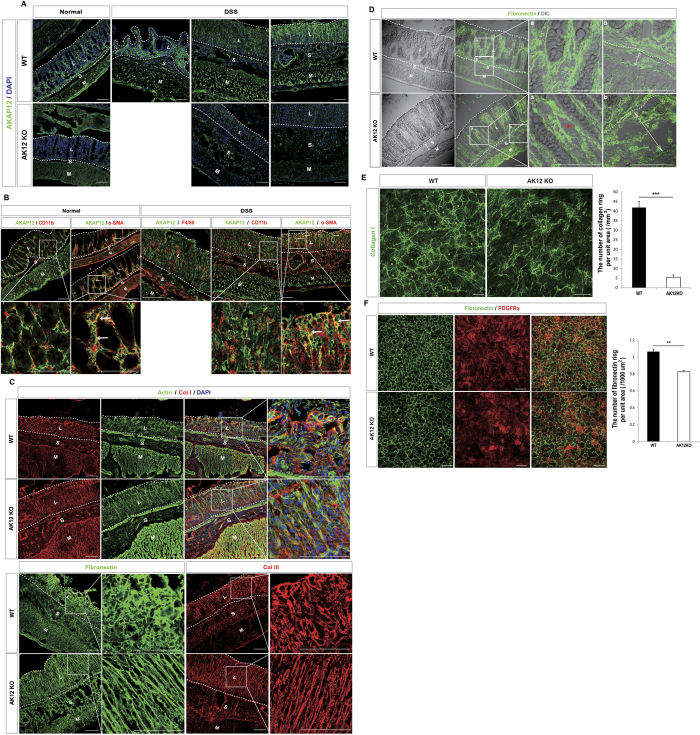
AKAP12+ CMCs regulates ECM organization.(A) Confocal imaging of AKAP12 expression in WT and AKAP12 KO colon during normal and inflammation condition. Bars: 100 μm. (B) Localizations of F4/80, CD11b, α-SMA with AKAP12 under conditions of normal and inflammation were tested to identify the cell type of AKAP12 (+) cells by confocal microscopy in intestinal inflammation. Co-localizations of α-SMA and AKAP12 were shown by white arrows. Bars: 100 μm. (C) Immunostaining for actin, collagen I, fibronectin, collagen III and cell nucleus in WT and AKAP12KO mice mucosa. Bars: 100 μm. ECM in dotted line was different in WT and AKAP12KO mice. (D) DIC image with immunostained fibronectin in WT and AKAP12 KO normal colon. Width of submucosa is marked by bi-directional white arrows. Fibronectin aberration is shown by red asterisk. Bars: 100 μm. (E) Immunostaining for collagen I in whole colon cell primary culture of WT and AKAPKO mice. Collagen ring structure is indicated by yellow asterisk. (n = 3 for WT or AKAP12 KO mice, respectively) Bars: 300 μm (F) Immunostaining for fibronectin and PDGFRα in whole colon cell primary culture of WT and AKAP12 KO mice. Fibronectin ring structure is shown by different sized yellow asterisk between WT and AKAP12 KO culture. (n = 3 for WT or AKAP12 KO mice, respectively) Bars: 100 μm. All images are representative of at least 3 mice per group. P## < 10−6, P# < 10−4, P*** < 10−3, P** < 10−2. Error bars, s.e.m.